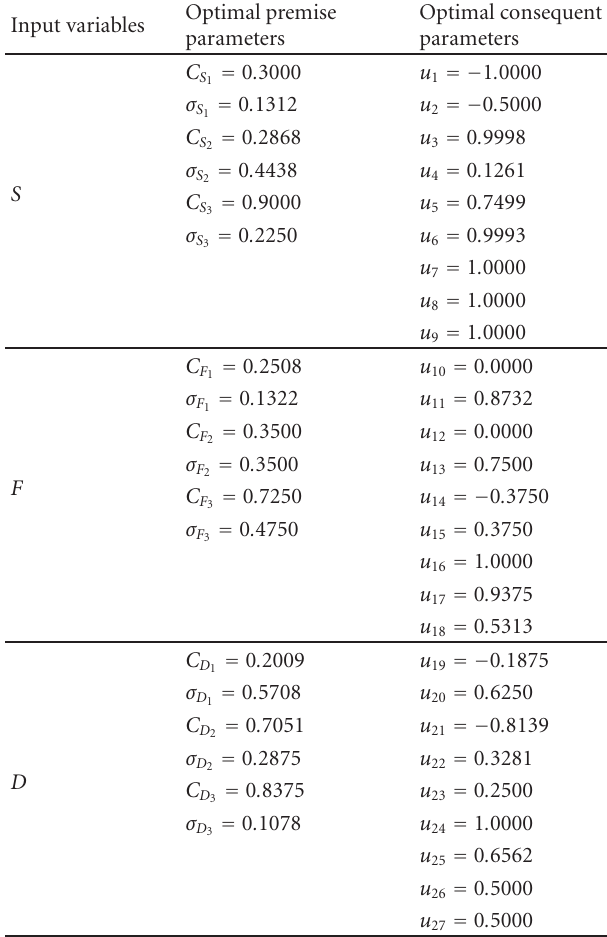
Table 11: Optimal premise and consequent parameters of ZO Sugeno model tuned by